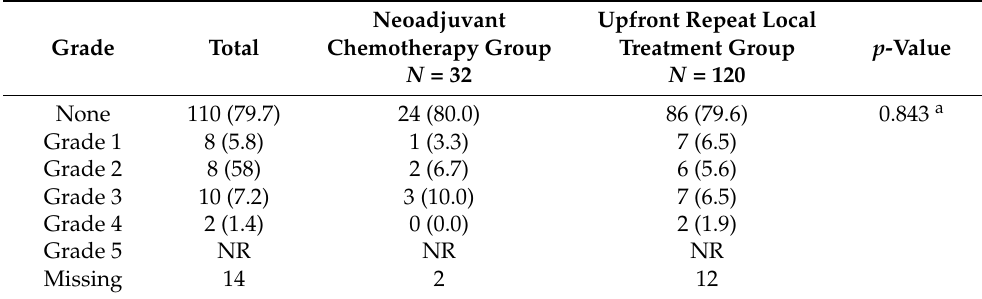
Table 5. Periprocedural complications of repeat local treatment (CTCAE) [71].